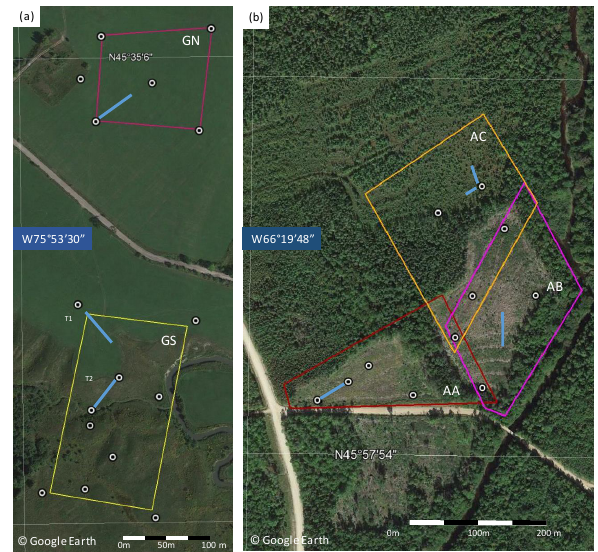
Figure 1. (a) Gatineau region showing the GN (pink) and GS (yel- low) sites and (b) Acadia region showing the AA (red), AB (ma- genta) and AC (gold) sites. Also indicated are ground control points (hollow circles) and in situ transects (blue lines). Map data: Google, Digital